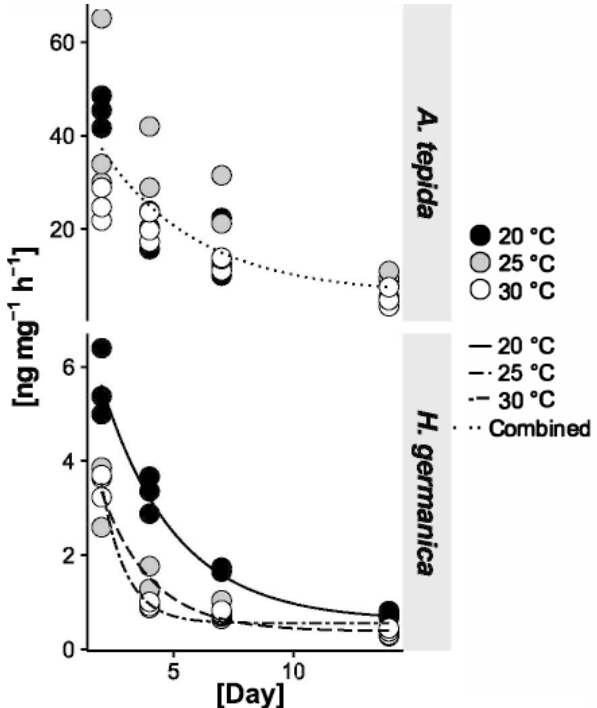
Figure 4. Carbon uptake rates. Uptake rates of phytodetrital carbon of A. tepida and H.germanica at three temperatures. Dots repre- sent the calculated uptake rates derived from isotope data per time, curves show functions of exponential decrease (curves are com- bined for A. tepida due to statistical